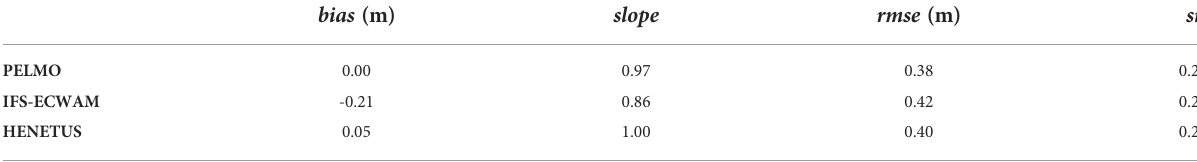
TABLE 6 Performance of PELMO in the calibration range (1.0 ≤ H s ≤ 3.0 m) at “ Acqua Alta ” tower station compared to IFS-ECMWF and